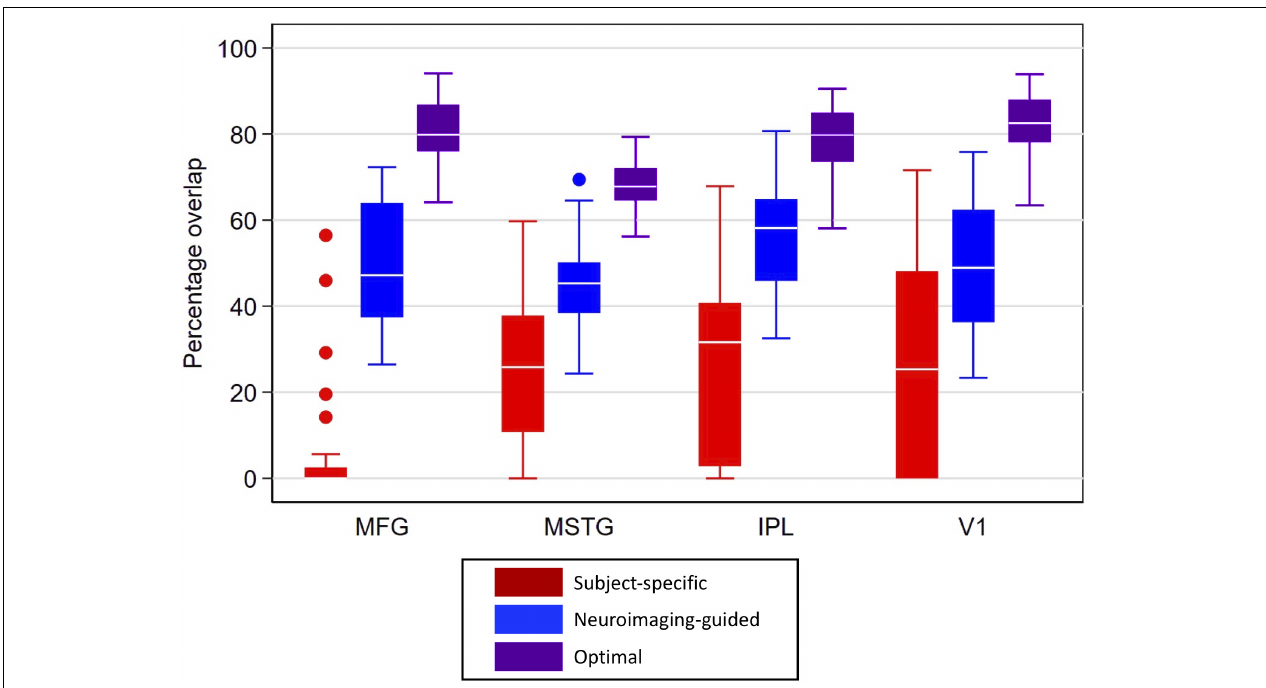
FIGURE 5 | Box plots for percentage overlap by method and region. Each box spans the 25th to 75th percentiles, with the mean indicated. The whiskers define 1.5 times the inter-quartile range; individual observations more extreme than this are indicated with dots. Image-guided sample selection, including both adjusting the anterior-posterior location of the selection as well as optimizing the angle markedly improved overlap with the reference sample compared to the overlap of the standard sample. MFG improved from 5.2% in the subject-specific sample to 80% in the optimal sample, MSTG improved from 24 to 68%, IPL improved from 27 to